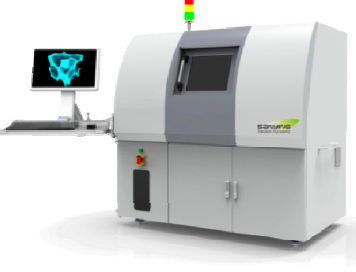
Figure 1. X-ray 3D microscope (NanoVoxel-2000).